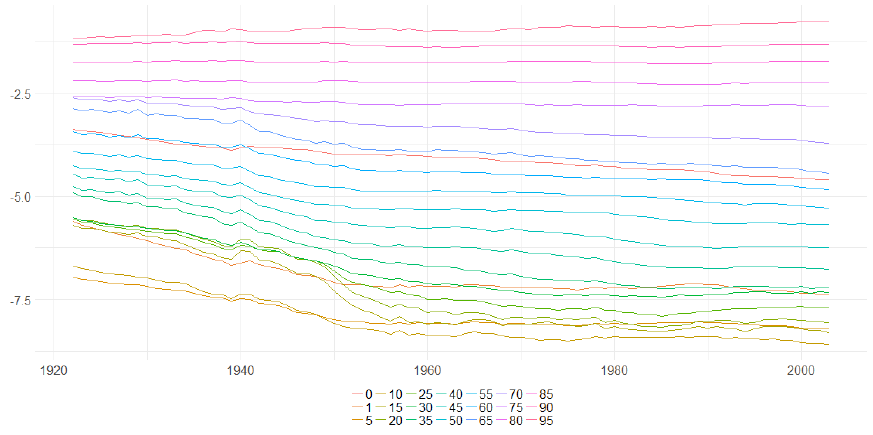
Figure 41. The Bayesian posterior mean estimates of α + ˜ F t (cid:36) T lines are related to the age groups (the elements of the vector α )